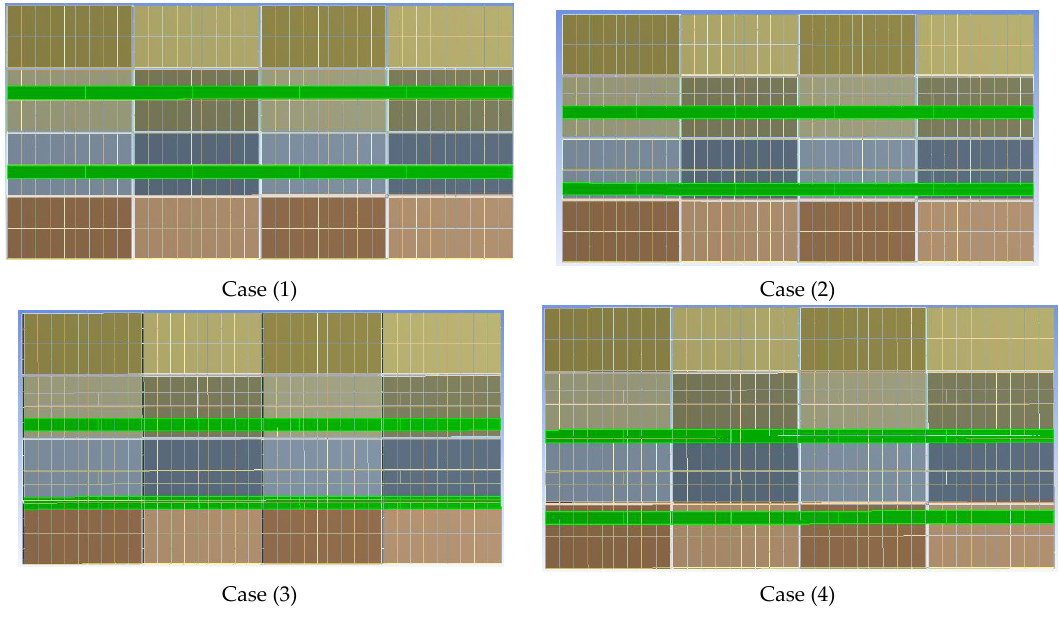
Figure 7. The four cases of loading. Case (1) centered load (no eccentricity); Case (2) transversely eccentric from the center (0.5 m); Case (3) transversely eccentric from the center (1 m); Case (4) transversely eccentric from the center (1.5 m).